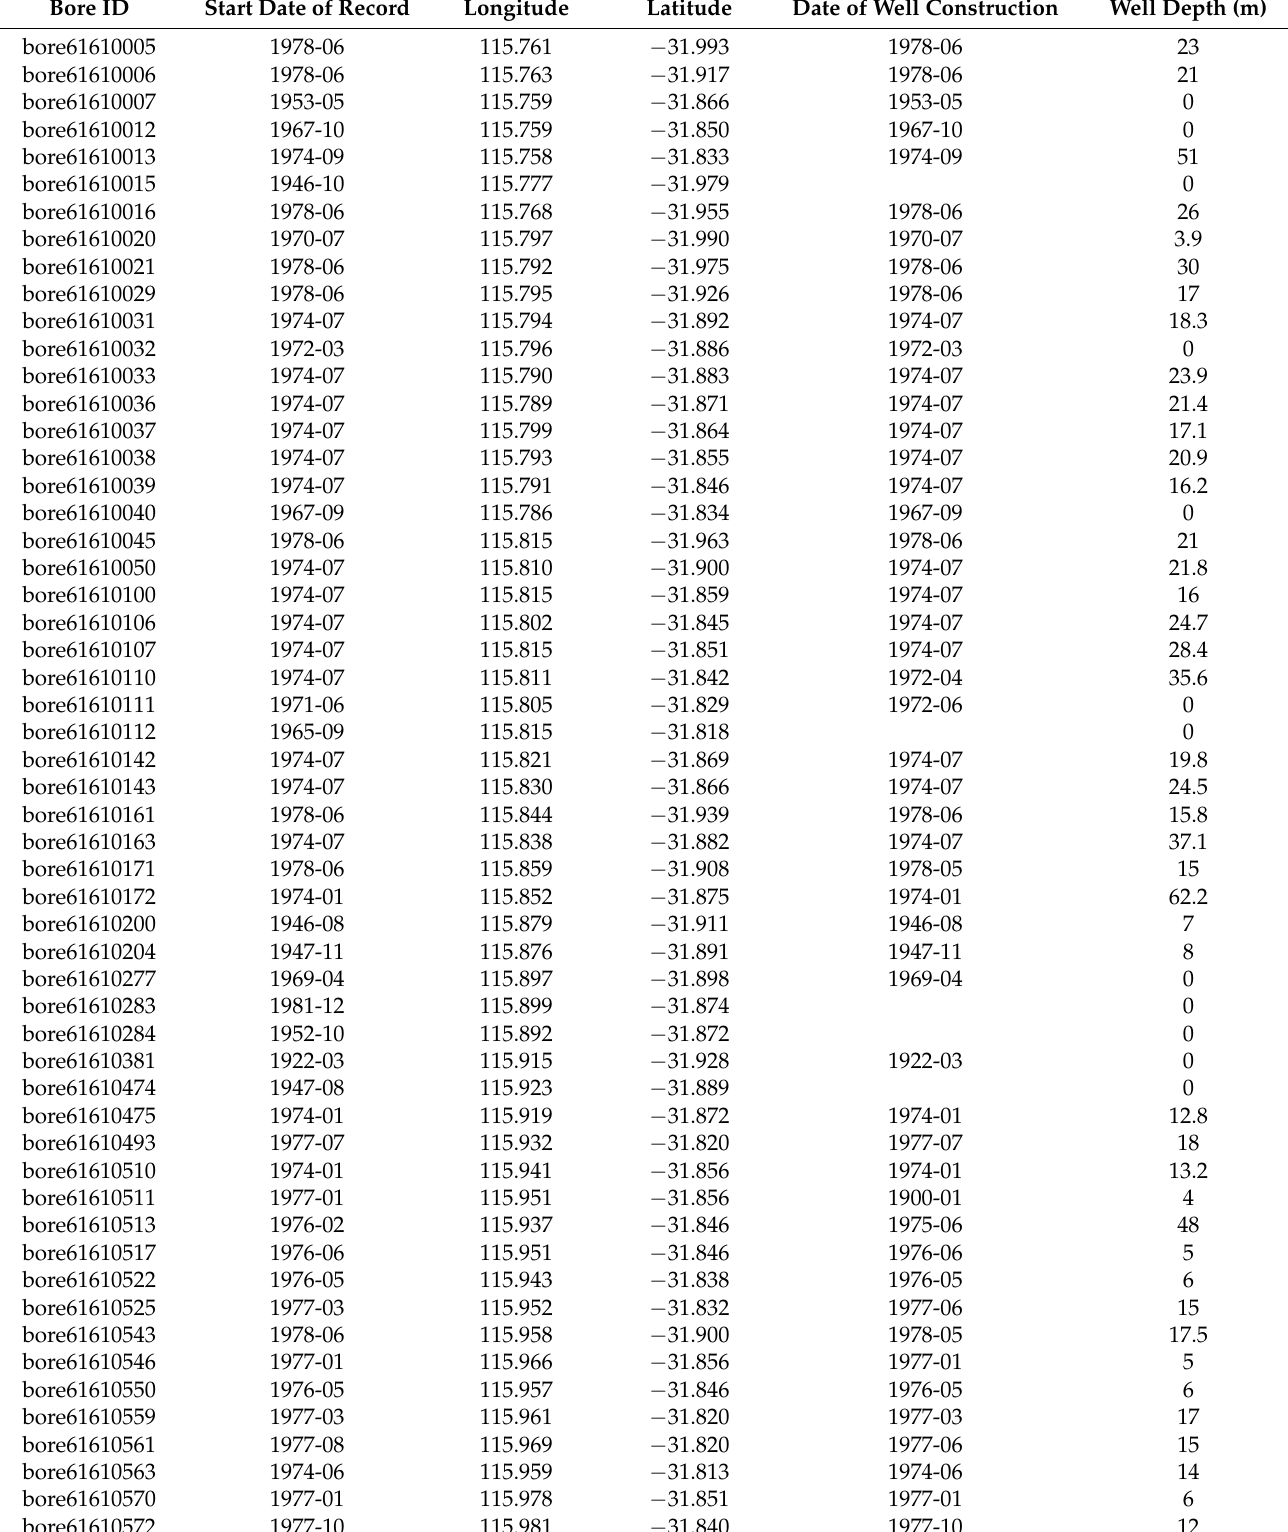
Table A1. Instructions of the groundwater level monitoring